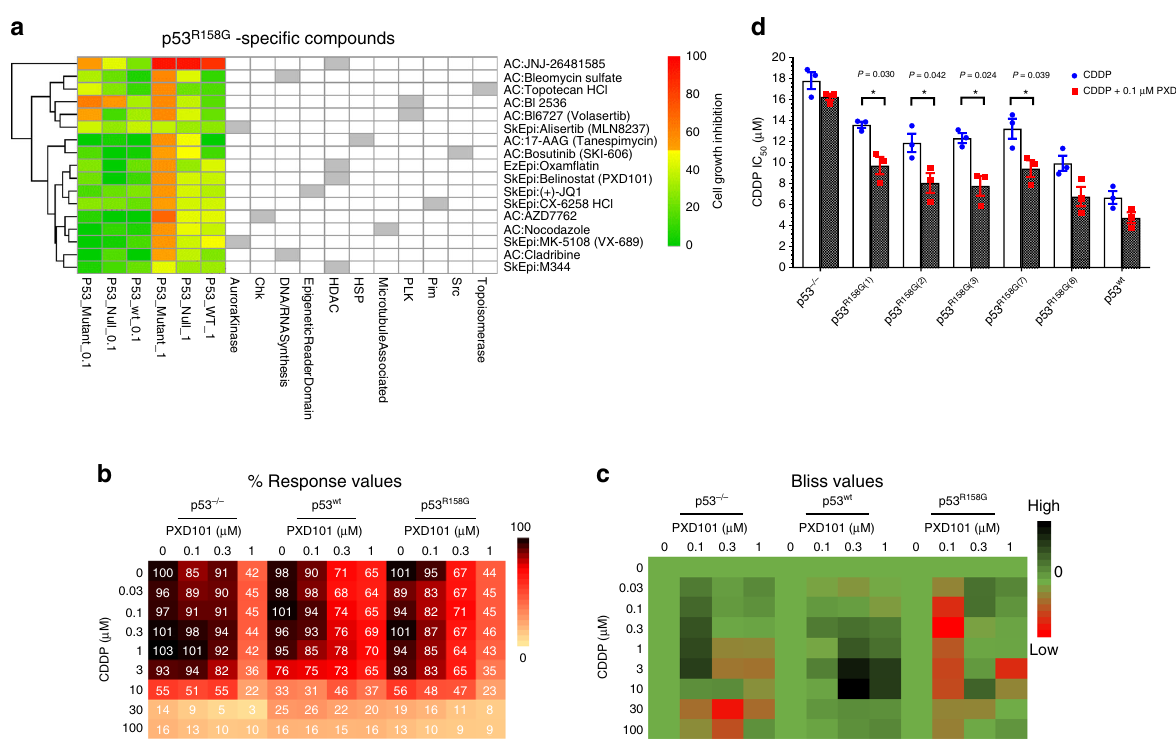
Fig. 2 High-content screening reveals compounds selective for p53 R158G cells. a High-content screening of anti-cancer compounds and epigenetic modulators on p53 clones. The ef fi cacy of the tested compounds was quanti fi ed relative to the mean viability of vehicle-treated cells (384-well format, in triplicates) 72 h post-treatment ( n = 1). Heatmap shows compounds fi ltered for speci fi city to p53 R158G cells (growth inhibition > 50% in p53 R158G ; <50% in p53 − / − , p53 wt ). b , c Response pro fi le for belinostat (PXD101) and cisplatin (CDDP). Percent response values represent normalized growth relative to vehicle control ( b ). Data are presented as mean cell viability ( n = 3 independent experiments). Viability response of belinostat/cisplatin combination from b was evaluated using the Bliss combination model ( c ). Bliss Scores are shown, with lower scores (synergy) highlighted in increasingly sharper shades of red. High Bliss values (CI > 0) indicate antagonism; low values (CI < 0) indicate synergy ( n = 3 independent experiments). d Cisplatin IC 50 , with or without belinostat (0.1 µ M), was tabulated for Calu-1 isogenic cells (p53 − / − , p53 wt , p53 R158G ). Cell viability was measured with MTS assay 72 h